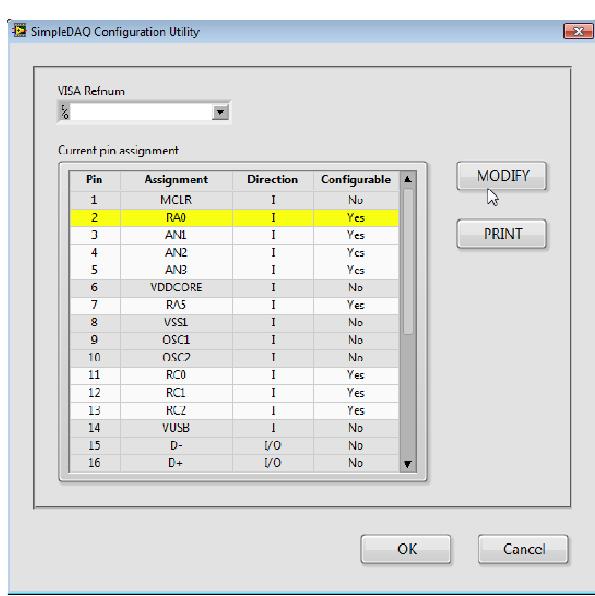
Figure 8. SimpleDAQ configuration utility.